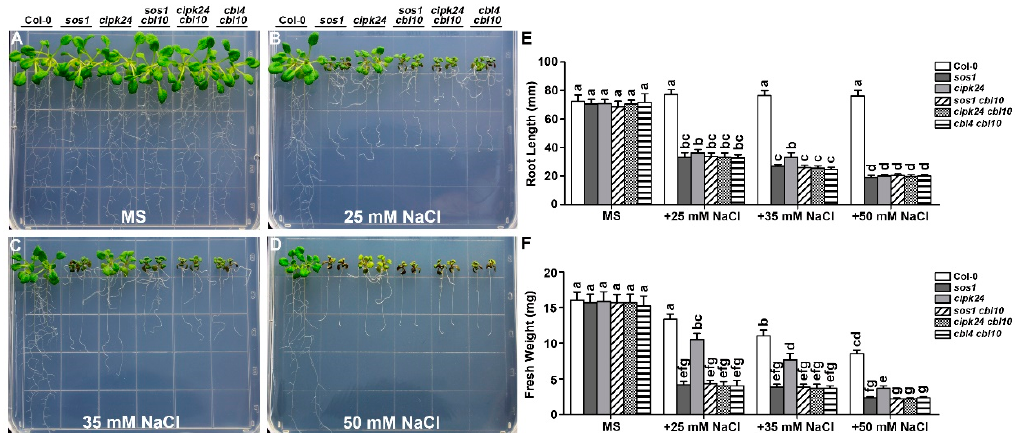
Figure 4. The cipk24 cbl10 and cbl4 cbl10 double mutants are more sensitive to external Na + than the cipk24 single mutant. ( a–d ) Five-day-old seedlings of each genotype were transferred onto the MS medium or MS supplemented with 25 mM, 35 mM and 50 mM NaCl. Photographs were taken on the 14th day after the transfer; ( e ) length of primary roots and ( f ) fresh weight of seedlings of each genotype on the 14th day after the transfer. Data are presented as the mean ± SE of triplicate experiments. Values labeled with different letters are significantly different ( p < 0.05).